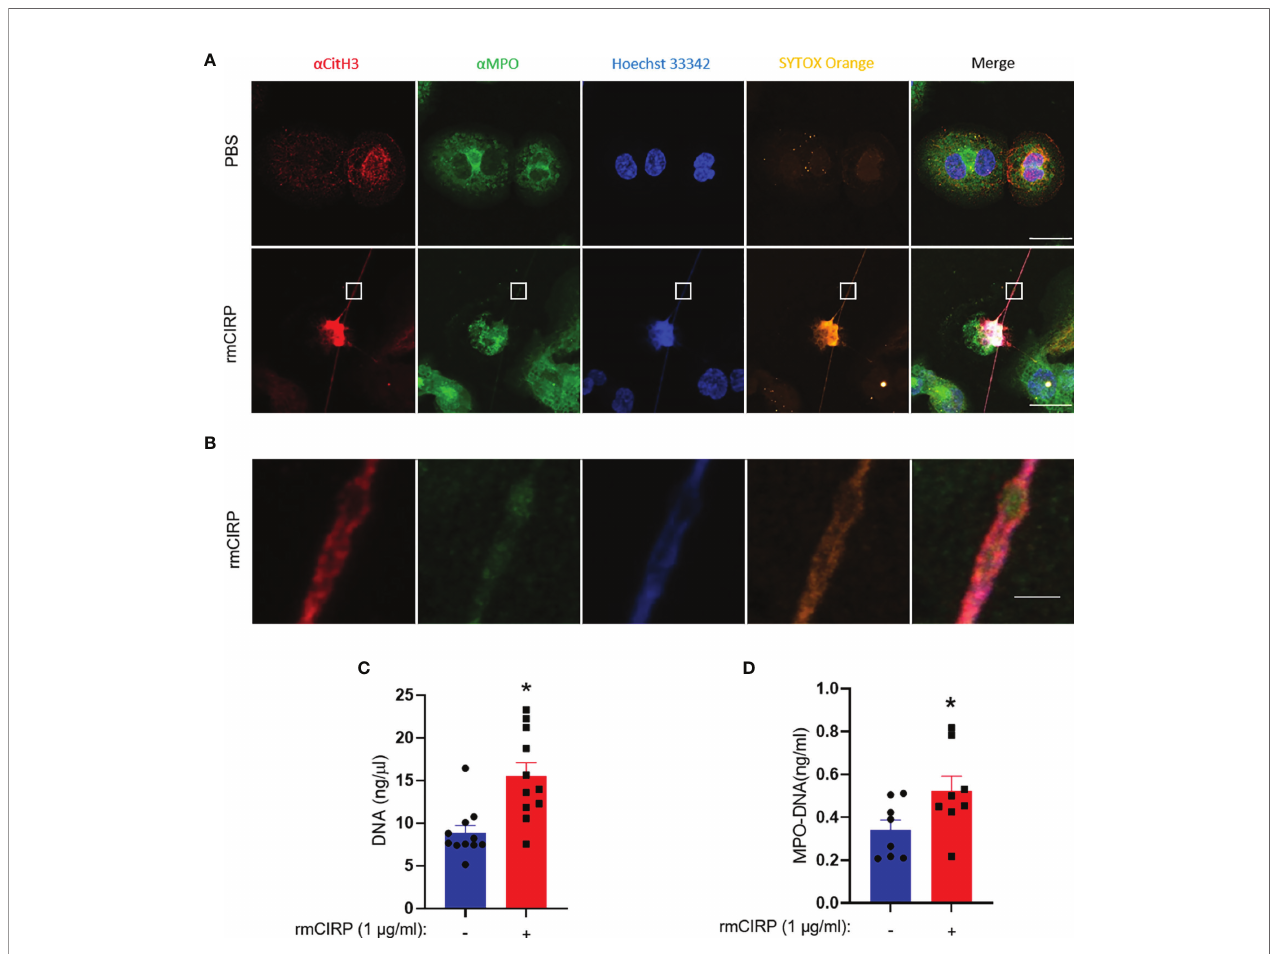
FIGURE 4 | CitH3 and MPO are released with DNA from THP-1 cells treated with rmCIRP. (A) rmCIRP (1 µg/ml) induces citrullination of histone H3 in the released DNA. The immuno fl uorescence microscopy shows that rmCIRP signi fi cantly increases the citrullination of histone H3 of nuclear DNA, whereas no citrullinated histone H3 was detected in the nucleus of control cells. Scale bar, 20 µm. (B) The blown-up images of the white boxes show that CitH3 and MPO are colocalized in SYTOX Orange positive extracellular DNA. Scale bar, 2 µm. (C) METs released in the culture media were quanti fi ed by UV spectrometer. Student t -test: *p <0.01 vs. PBS (without rmCIRP). (D) ELISA quanti fi ed MPO – DNA released in the culture media. Student t -test: *p <0.05 vs. PBS (without